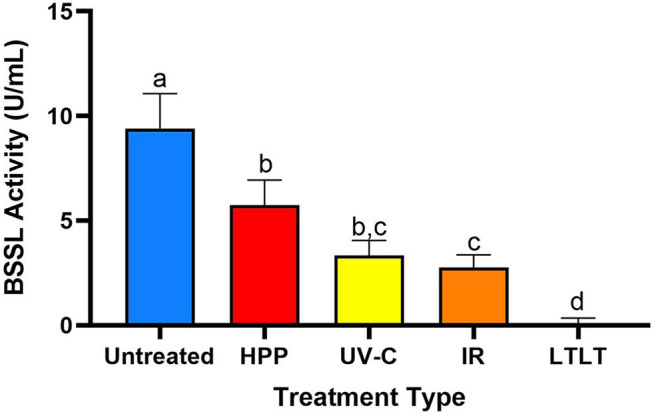
Bile salt-stimulated lipase activity in untreated donor breast milk and donor milk treated by HPP, UV-C (16,500 J/L), IR and LTLT. Different letters indicate that the samples are significantly different at p < 0.05.